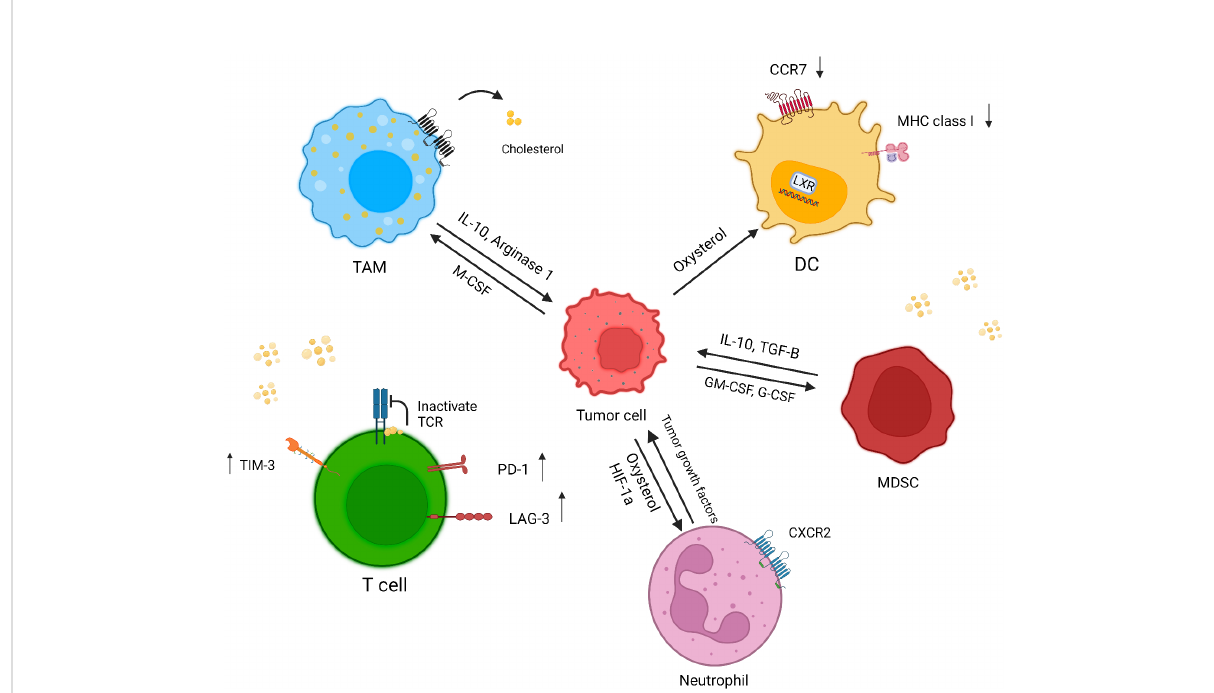
FIGURE 2 Effect of a cholesterol-rich tumor microenvironment on immune cells. Increased cholesterol ef fl ux from macrophage membranes induces the M2 phenotype in tumor resident macrophages. In cholesterol-rich area, T cells overexpress exhaustion markers, and cholesterol binds to the TCR b - chain and puts T cells in a resting state. Oxysterol recruits CXCR2-positive neutrophils, which in turn induces angiogenesis and tumor growth. Tumor-released factors induce MDSC suppressive responses through cholesterol accumulation. The accumulation of cholesterol in DCs causes a reduction in MHC class I and CCR7 expression, which diminishes the immune response against tumor cells (created with